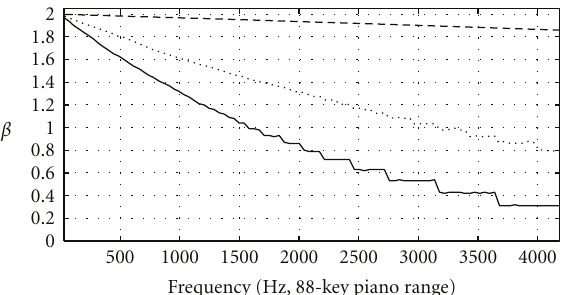
Figure 7: Stability (dashed) and aliasing (solid: f s = 44 . 1kHz, dotted: f s = 88 . 2kHz) limits of FBAM.